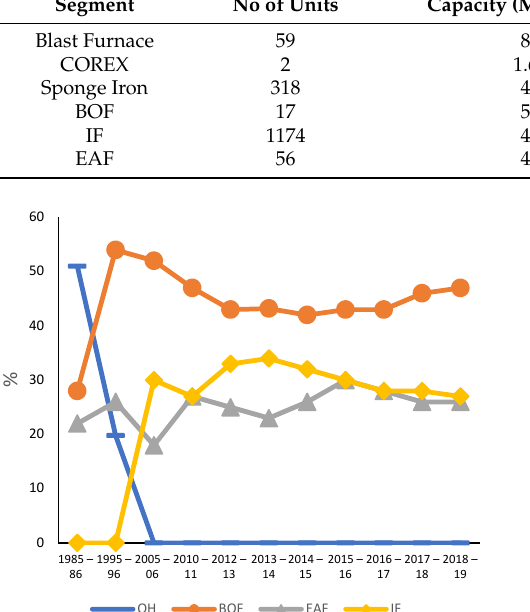
Figure 4. Crude steel production by process; share (%) OH—Open Hearth Process; BOF—Basic Oxygen Furnace; EAF—Electric Arc Furnace; IF—Induction Furnace. Graph plotted using data from India Brand Equity Foundation [4].